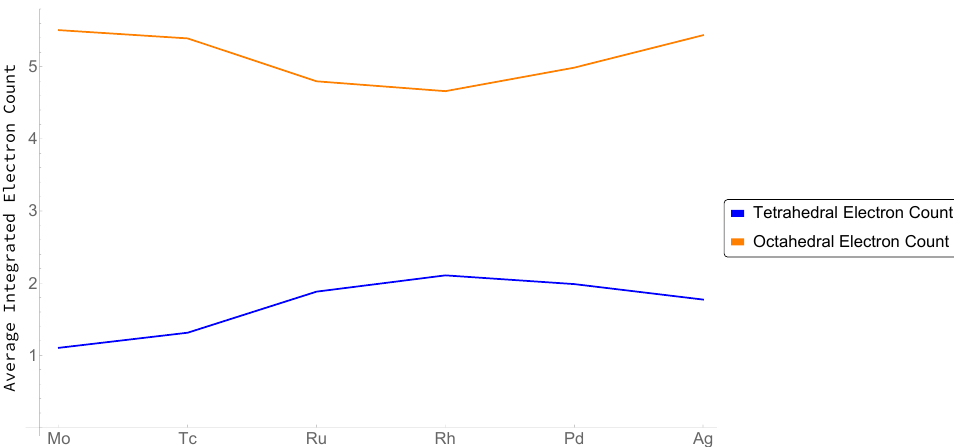
Figure 8. Integrated electron count in the Tetrahedral (Blue) and Octahedral (Orange) hole across the FCC 4 d series. Lattice constants are provided in Table